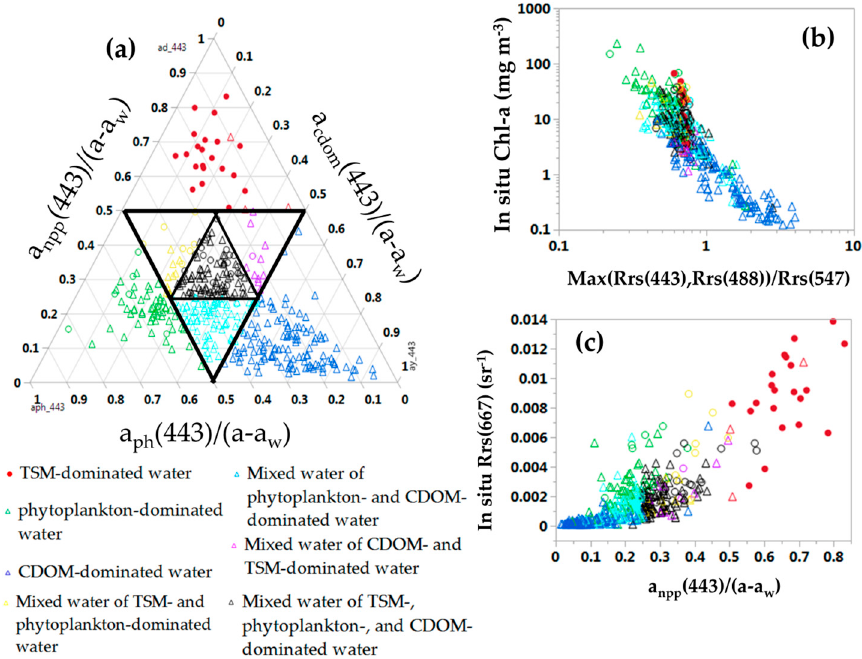
Figure 7. ( a ) Ternary plot of a ph (443), a y (443), and a npp (443) for data from Ariake Bay, the East China Sea, and Ise Bay. The value on each side represents the ratio of the corresponding water constituents of absorption to the total absorption. ( b ) Relation between Chl-a and OC3M band ratio. ( c ) Relation between in situ Rrs(667) and a npp( 443). Red, green, dark blue, yellow, light blue, purple, and black symbols represent the waters of TSM-dominated, phytoplankton-dominated, CDOM-dominated, a mixture of TSM-dominated and phytoplankton-dominated water, a mixture of phytoplankton-dominated and CDOM-dominated water, a mixture of CDOM-dominated and TSM-dominated water, and a mixture of TSM-dominated, phytoplankton-dominated, and CDOM-dominated water, respectively. Circles and triangles represent the Ariake Bay dataset and combined data from Ise Bay and the East China Sea, respectively.